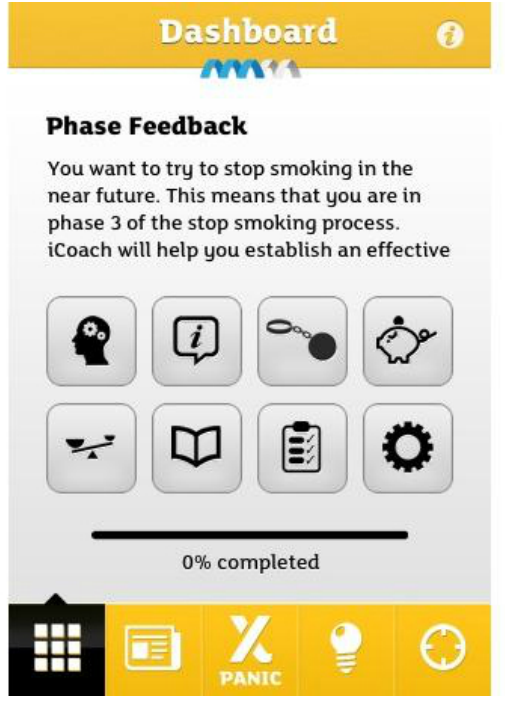
Figure 3. Screenshot of the FCB/Exsmokers iCoach app by the European